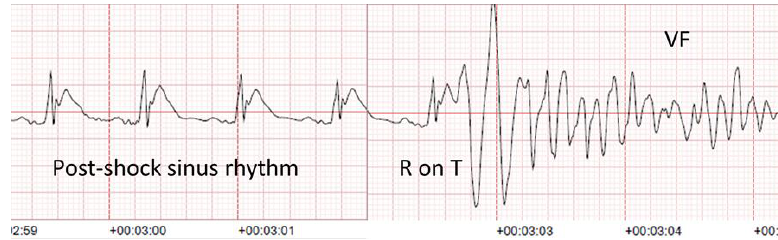
Figure 2. Spontaneous VF recurrence due to “R on T” phenomenon. Statistical Analysis